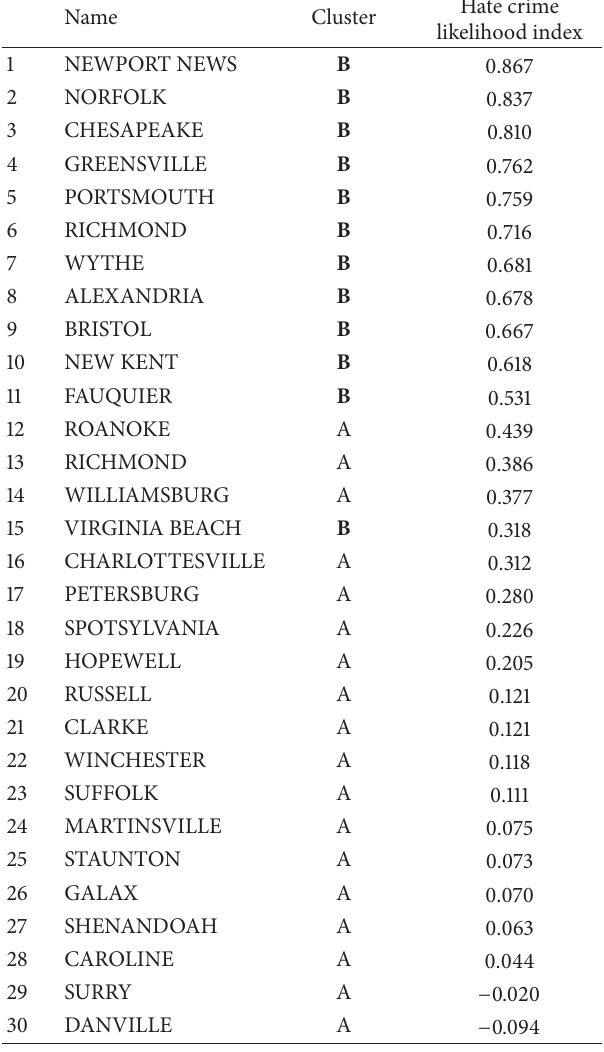
Table 2: Hate crime correlation coefficient vector values for other crimes.